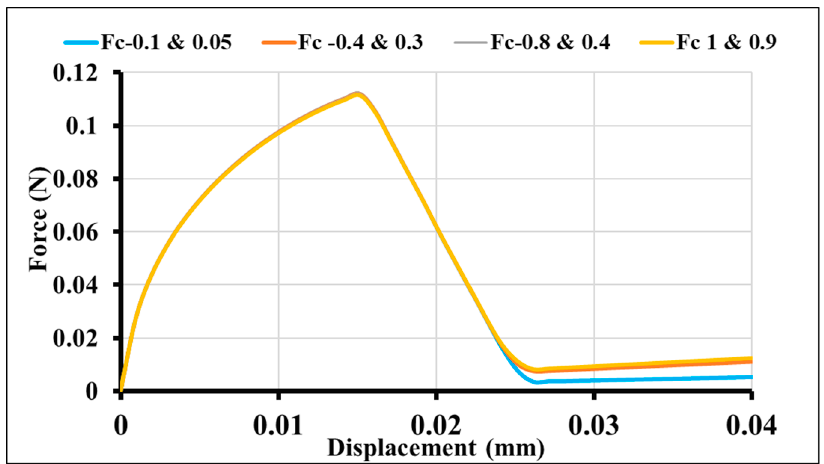
Figure 4. Force (or load)-displacement curve for varying coefficients of friction.